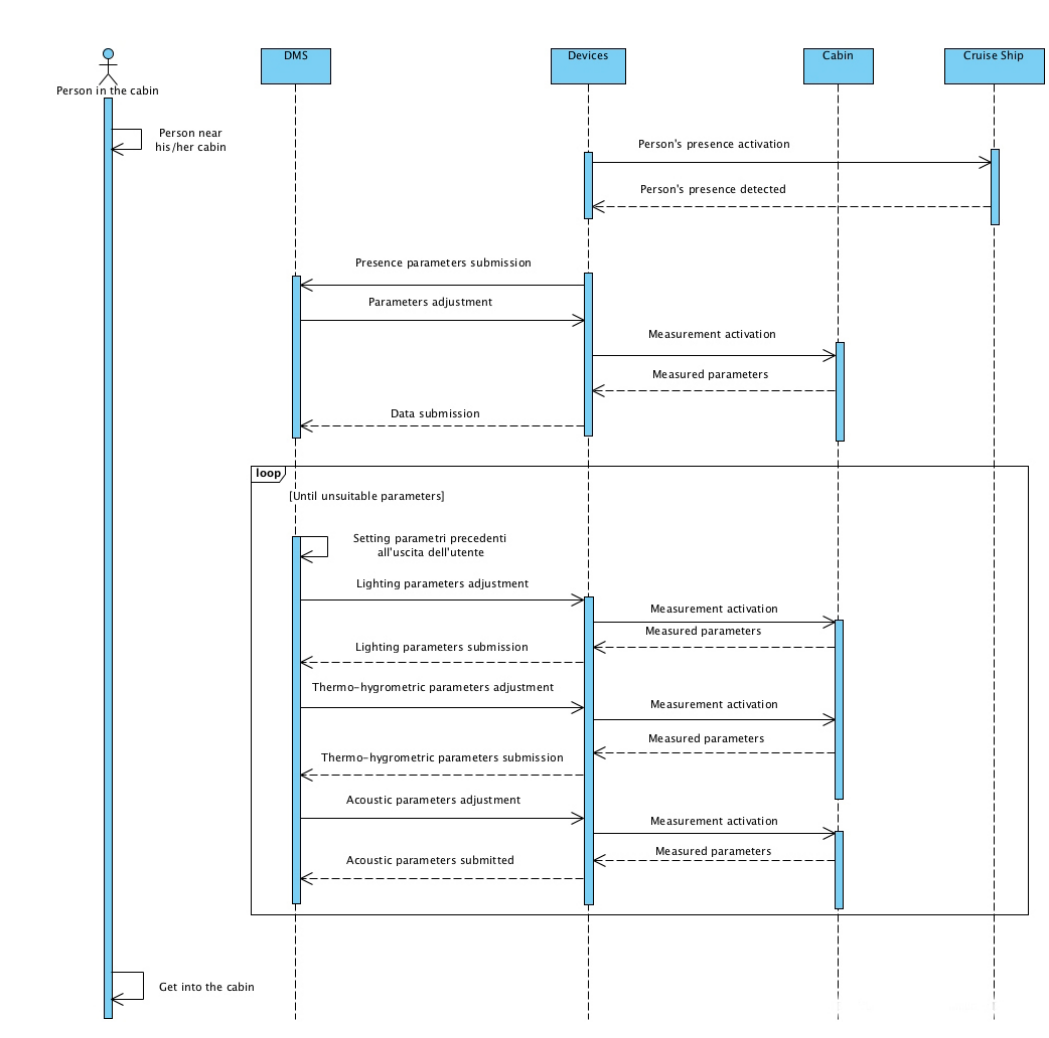
Figure 9. Sequence diagram for the Use Case